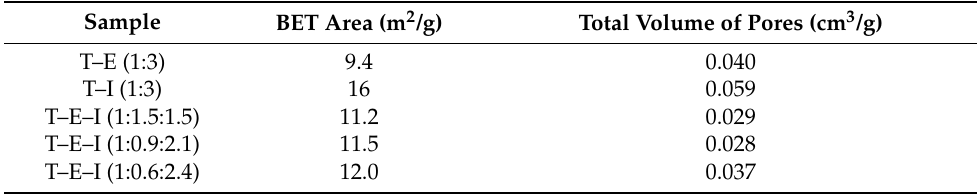
Table 3. Results of the BET analysis of the polyHIPEs.